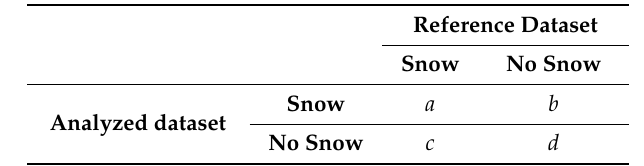
Table 8. Contingency table reporting number of HITS (a), number of FALSE ALARMS (b), number of MISSES (c), number of CORRECT NEGATIVES